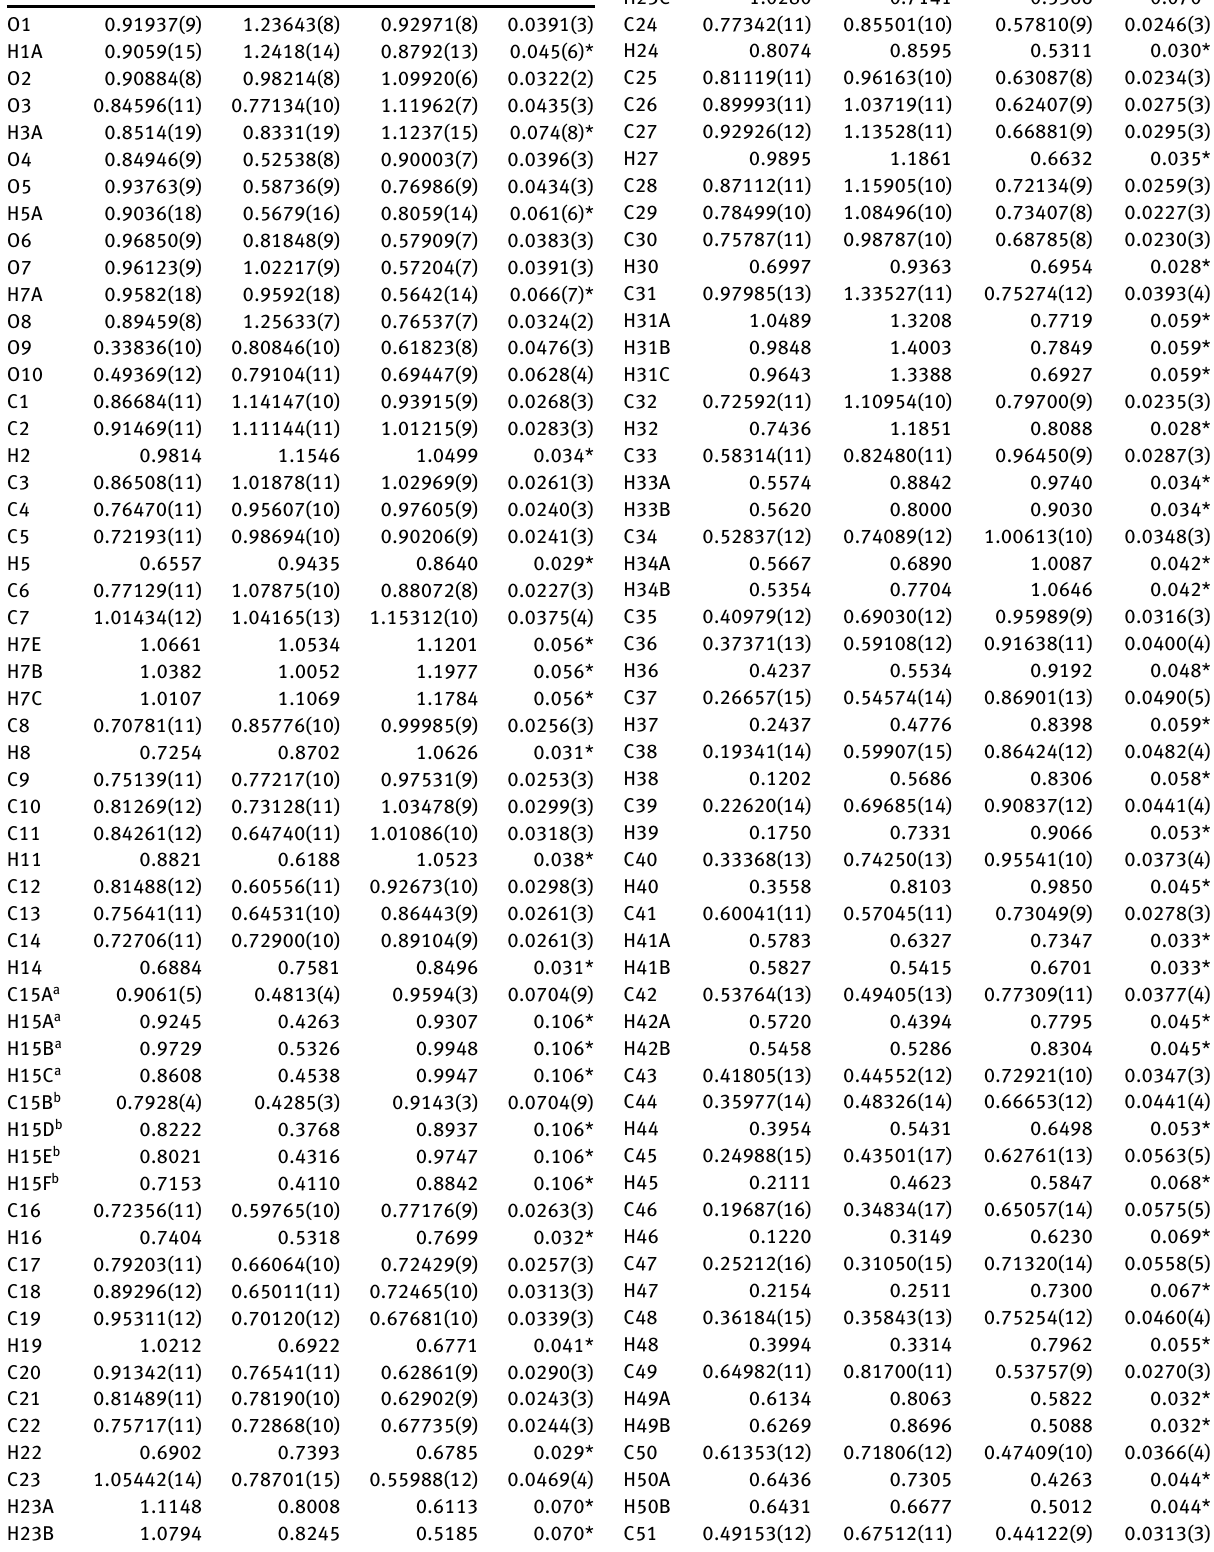
Table 2: Fractional atomic coordinates and isotropic or equivalent isotropic displacement parameters (Å 2